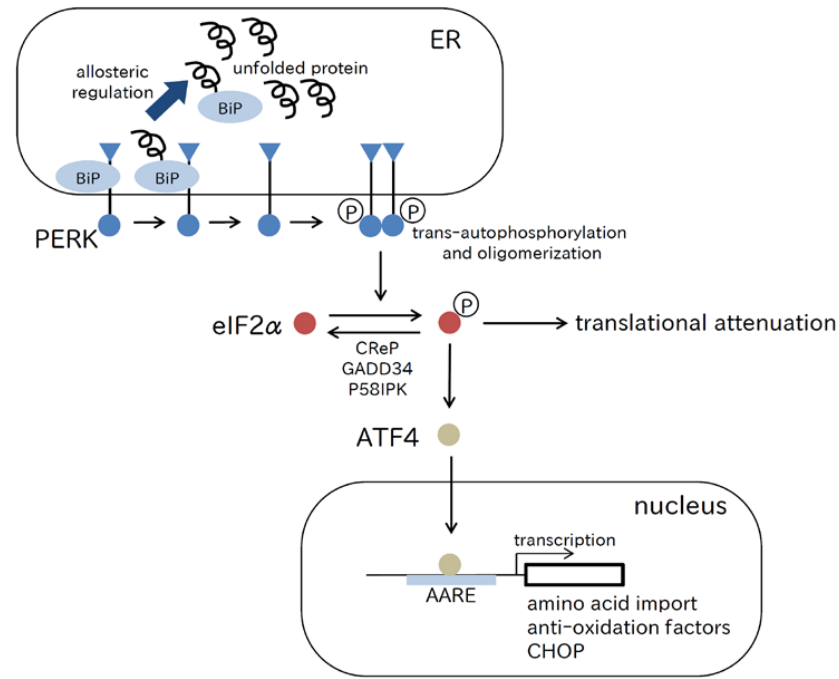
Figure 1. The PERK pathway. PERK oligomerizes and trans -autophosphorylates by detecting unfolded proteins in the ER, inactivates eIF2α by phosphorylation, and induces translation of ATF4. According to the current allosteric model of UPR induction, the ATPase domain of BiP interacts with the luminal domain of PERK that dissociates when an unfolded protein binds to the canonical substrate binding domain of BiP. ATF4 enhances transcription of genes involved in amino acid transport, oxidative stress, and apoptosis. Phosphorylated eIF2α is dephosphorylated by CReP, GADD34, and P58IPK. AARE, amino acid response element; ATF4, activating transcription factor 4; CHOP, C/EBP-homologous protein; CReP, constitutive repressor of eIF2α phosphorylation; eIF2α , eukaryotic translational initiation factor 2; GADD34, growth arrest and DNA damage 34; PERK, PKR-like endoplasmic reticulum kinase; P58IPK, 58 kDa-inhibitor of protein kinase.